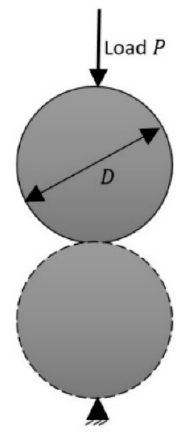
( b ) Figure 10. Cylinder under load P solve with FEM. ( a ) Mesh used in FEM software. ( b ) Cylinder deformed solved with FEM software; the plot colors represent the displacement in Y direction. 4.2. Plane Strain Problem-Solve with Conventional BEM The strain problem of Figure 8 was solved with a program based on BEM and the algorithm proposed by [25]. To solve the problem, the following data was used: 71 nodes, 36 elements distributed on the boundary (Figure 11a), 6 integration points for Gaussian Quadrature, quadratic shape functions to describe tractions and displacements, and the data from Table 1. The result can be found in Figure 11b. To generate the internal displacements, 13 internal points were chosen using the guidelines described by [25].